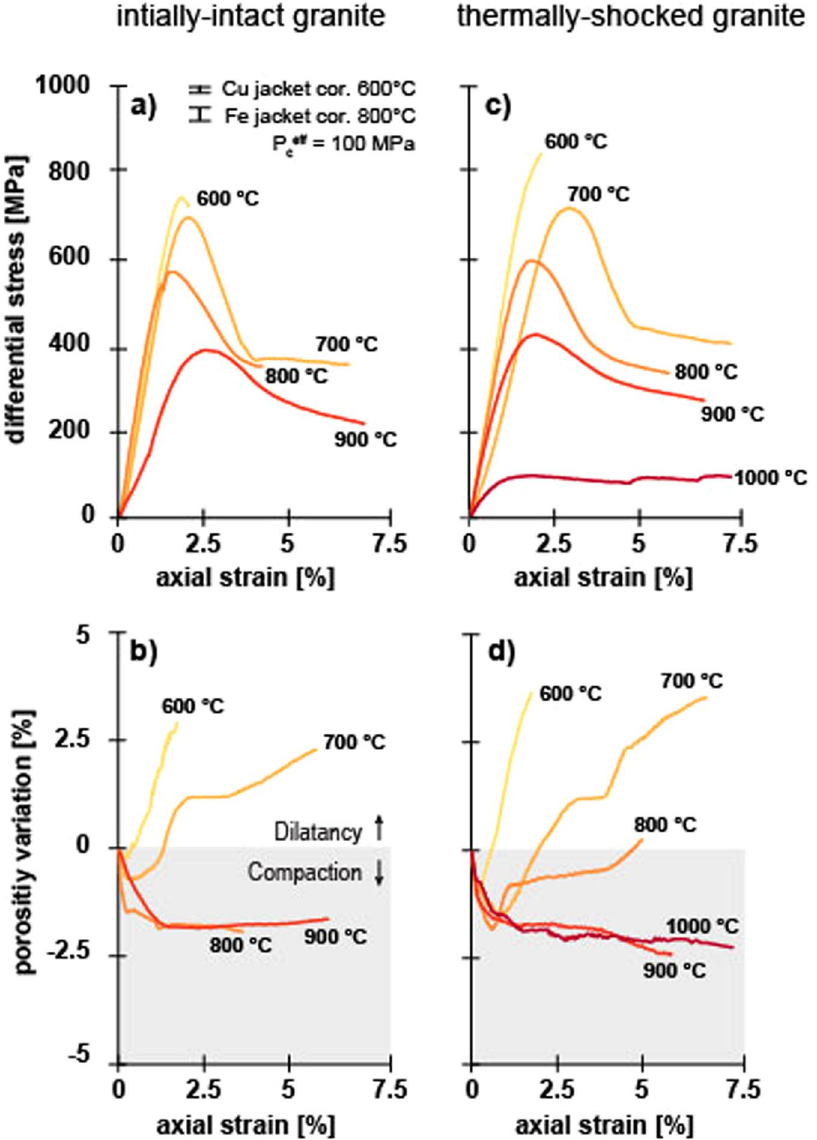
Figure 2. Mechanical data and porosity evolution for triaxial deformation experiments performed at temperatures between 600 and 1000 °C and an effective confining pressure of 100 MPa. Samples were deformed in compression at an axial strain rate of 10 − 5 s − 1 . ( a ) and ( b ) show the mechanical behaviour and porosity evolution, respectively, for samples of initially-intact Westerly granite. ( c ) and ( d ) show the mechanical behaviour and porosity evolution, respectively, for samples of Westerly granite thermally-shocked to 450 °C. Porosity data were smoothed with the 1D digital filter of